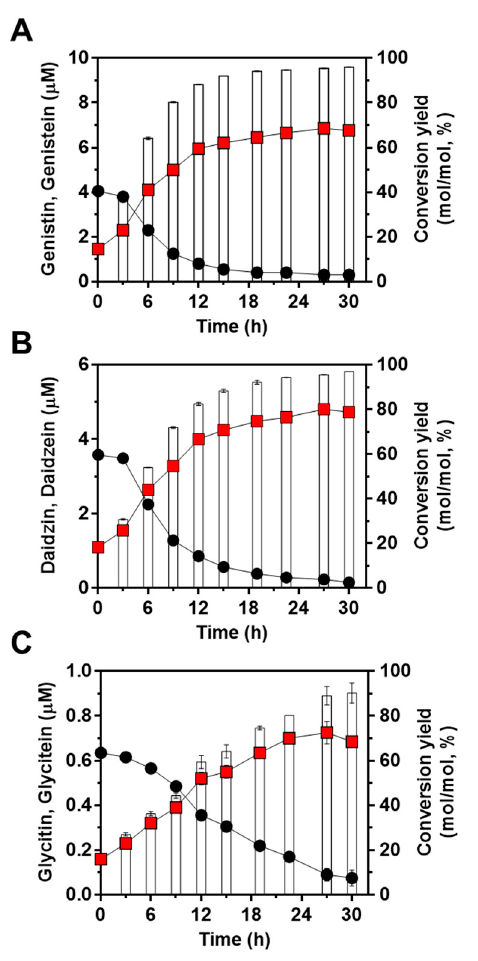
Figure 6. Bioconversion of isoflavones during soymilk fermentation by L. citreum harboring pCB4270V4-IH. ( A ) Production profiles of genistein. ( B ) Production profiles of daidzein. ( C ) Production profiles of glycitein. Symbols: black circle, isoflavone glycoside forms in soymilk; red square, isoflavone aglycone forms in soymilk; white bar, conversion yields of isoflavones in L. citreum harboring pCB4270V4-IH. Results are the mean of triplicate experiments, and error bars indicate standard deviations.